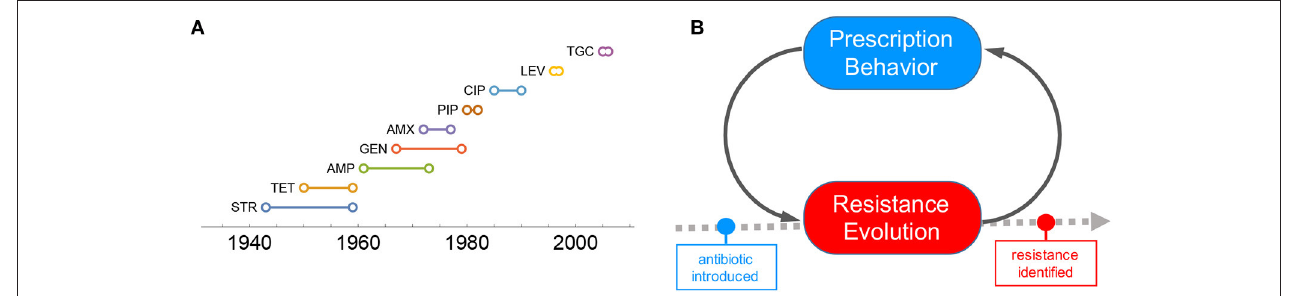
FIGURE 1 | Problem of antibiotic resistance. (A) Timeline plot of resistance emergence for common antibiotics. The time period of an antibiotic’s effectiveness from its introduction to first resistance identified becomes increasingly short. (B) Prescribing behavior is one of the driving factors contributing to the fast emergence of resistance. The interaction between resistance evolution and prescripting behavior plays an important role in determining the timeline of resistance